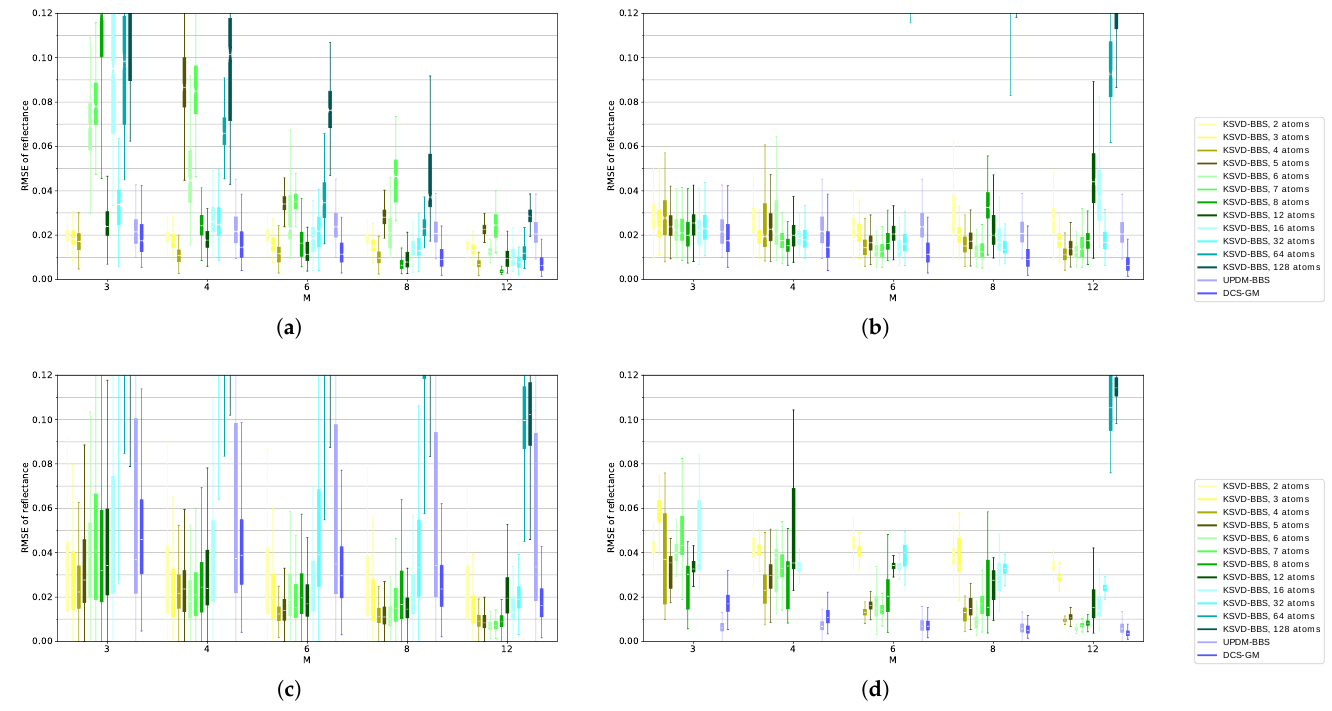
Figure 7. The evaluation results for different dataset combinations. ( a ) Training: Air_MA , Band Selection: Air_MB , Evaluation: Ground_Full , ( b ) Training: Air_V1 , Band Selection: Air_V2 , Evaluation: Ground_Full , ( c ) Training: Ground_V1 , Band Selection: Ground_V2 , Evaluation: Air_Full , ( d ) Training: Ground_V1 , Band Selection: Ground_V2 , Evaluation: Air_V1